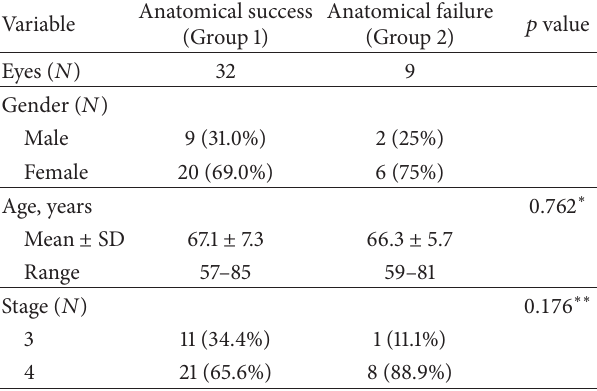
Table 1: Baseline parameters and demographic